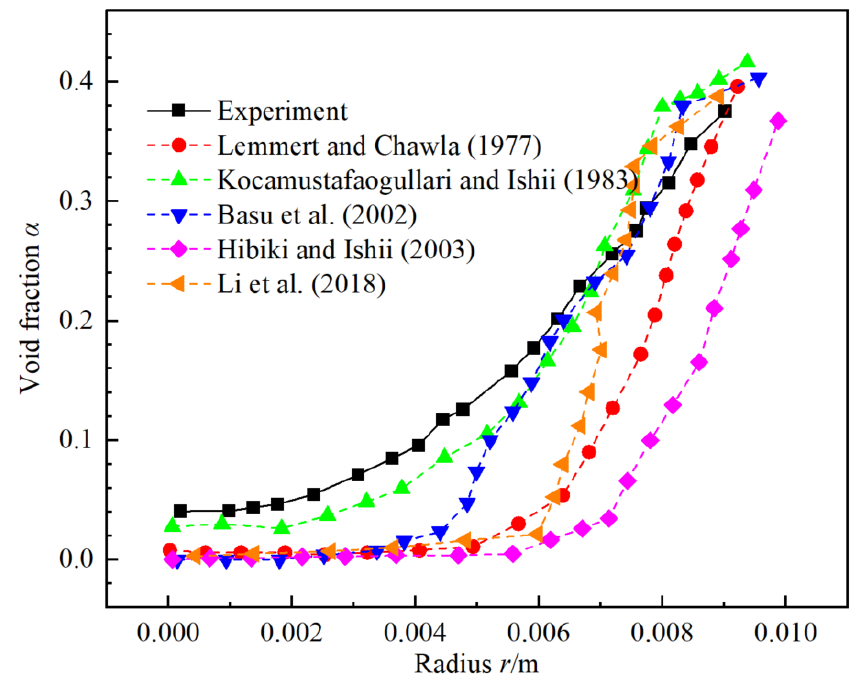
Figure 5. Void fraction α distribution of various typical models of N n with model of D d [8], f [46], a ( d i , d j ) [57], Ω ( V p ), β ( f bv , 1) [54] and DEBORA-1 experiment ( P = 2.62 MPa) [28] at z = 3.5 m.